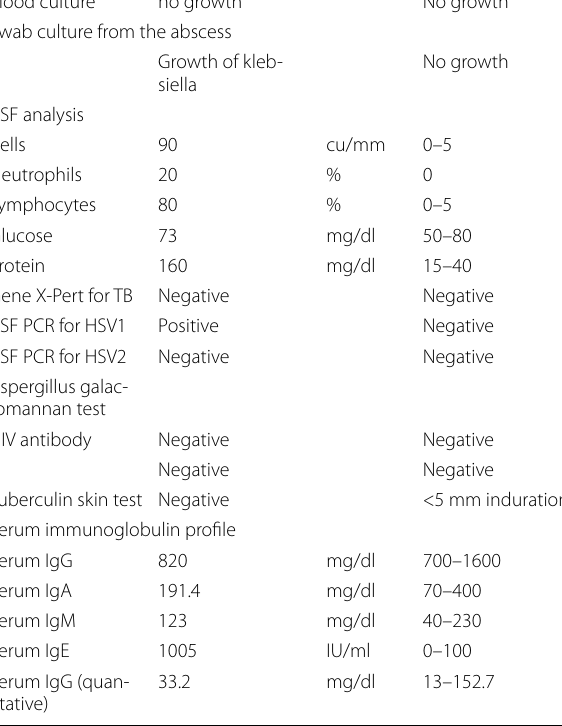
• Hyper IgE syndrome, Herpes simplex viral enceph-